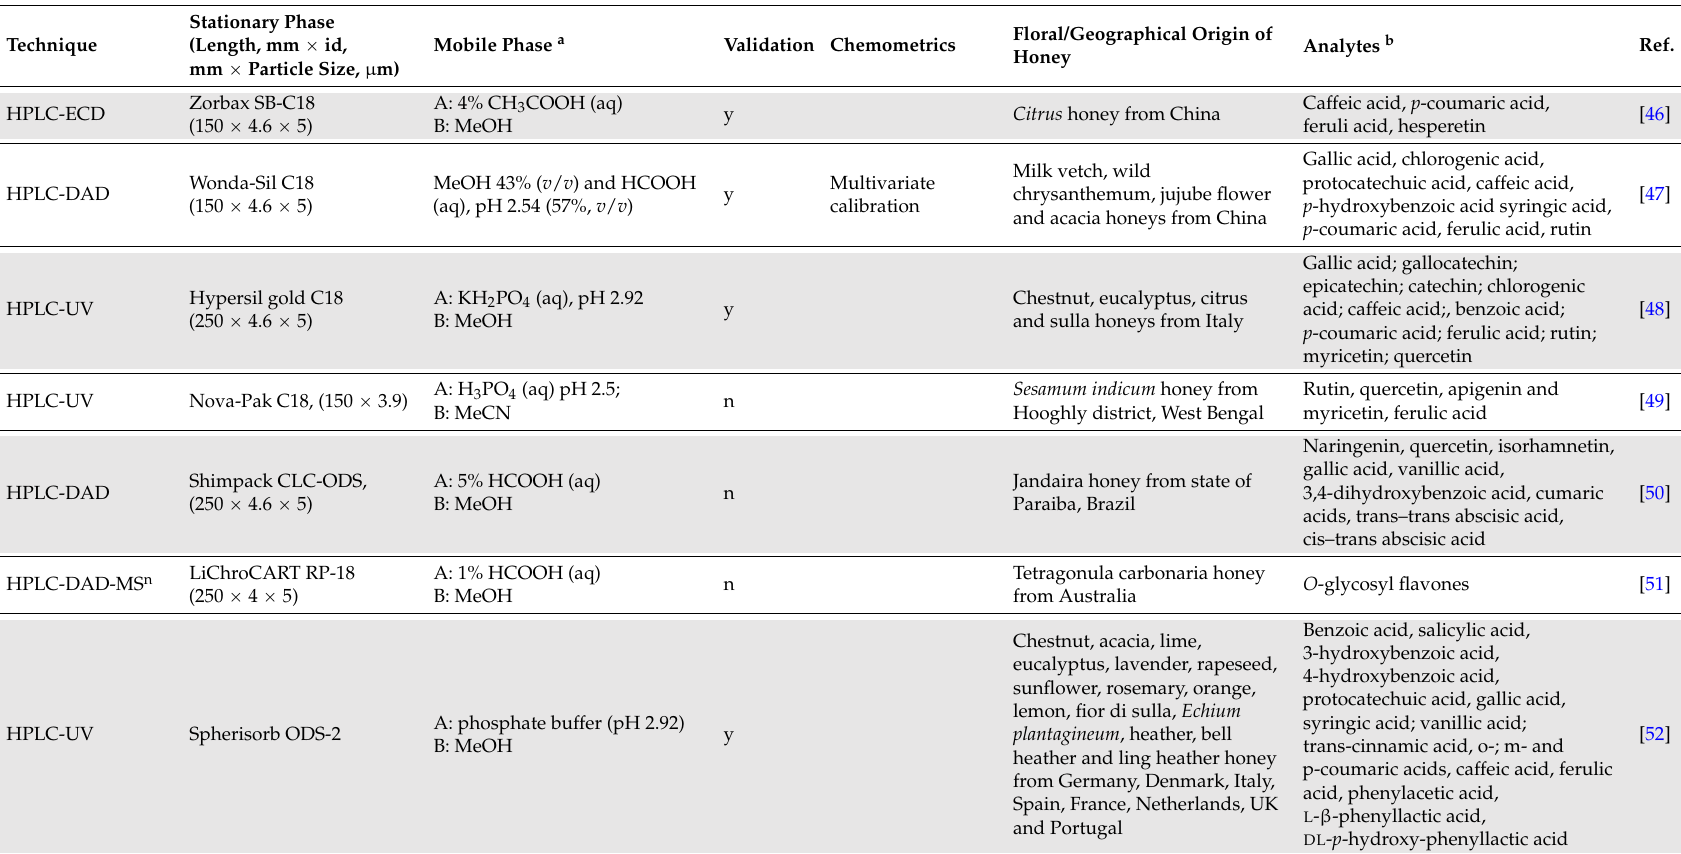
Table 1. Features of recent chromatographic methods for the analysis of phenolic compounds in unifloral